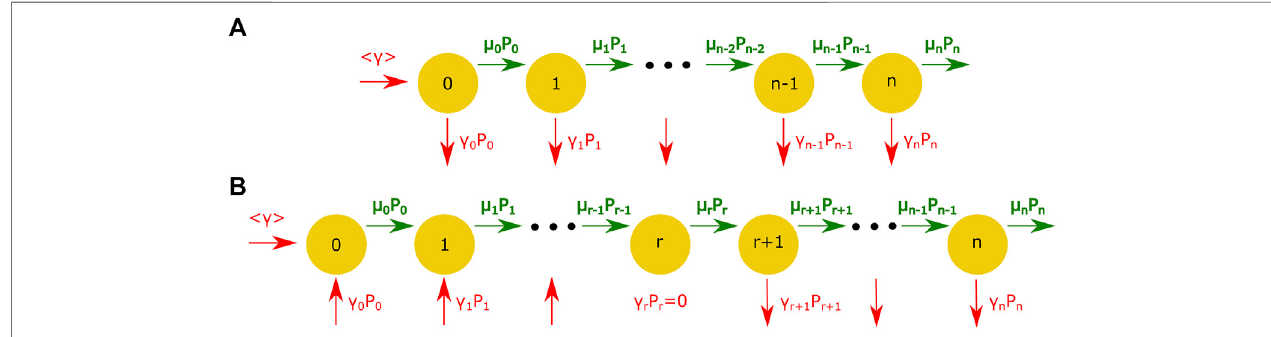
FIGURE5| Illustrationofthegrowthandresetprocess: (A) thegeneralmechanismoftheprocesswithapositiveresetrate, (B) theprocessconsideringaresetrate which can be both positive and negative.